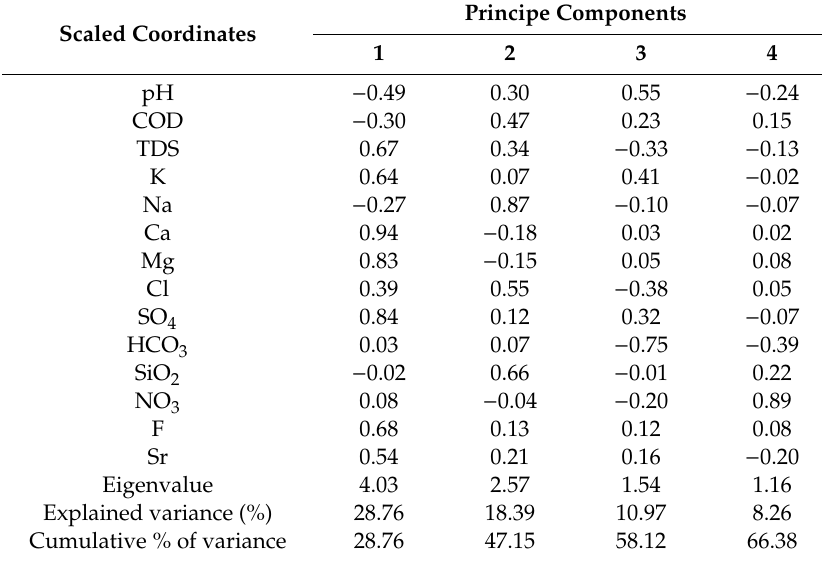
Table 3. Principal component loadings and explained variance for the three components. Scaled